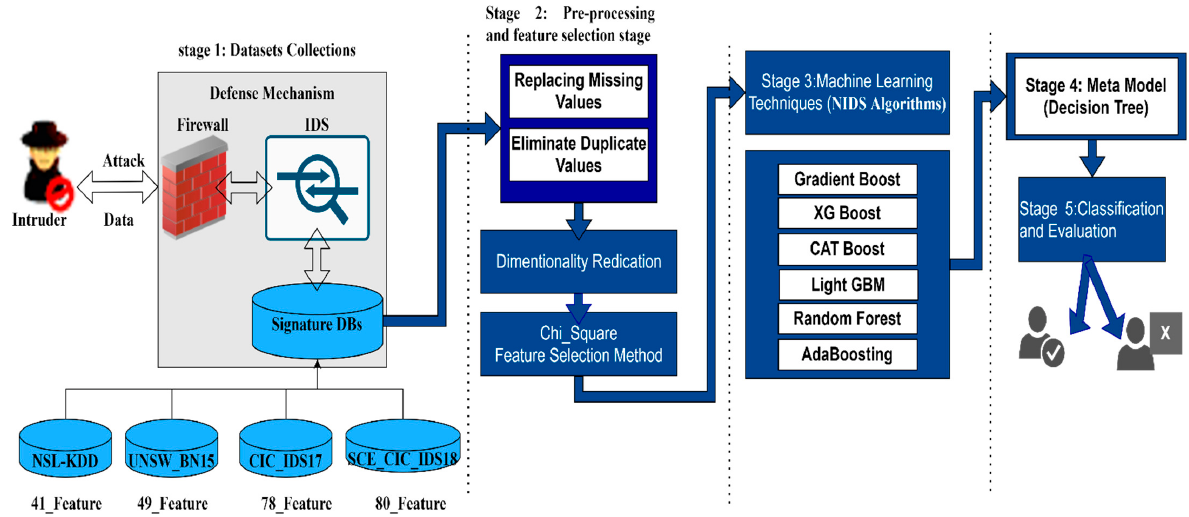
Figure 2. The proposed system’s general